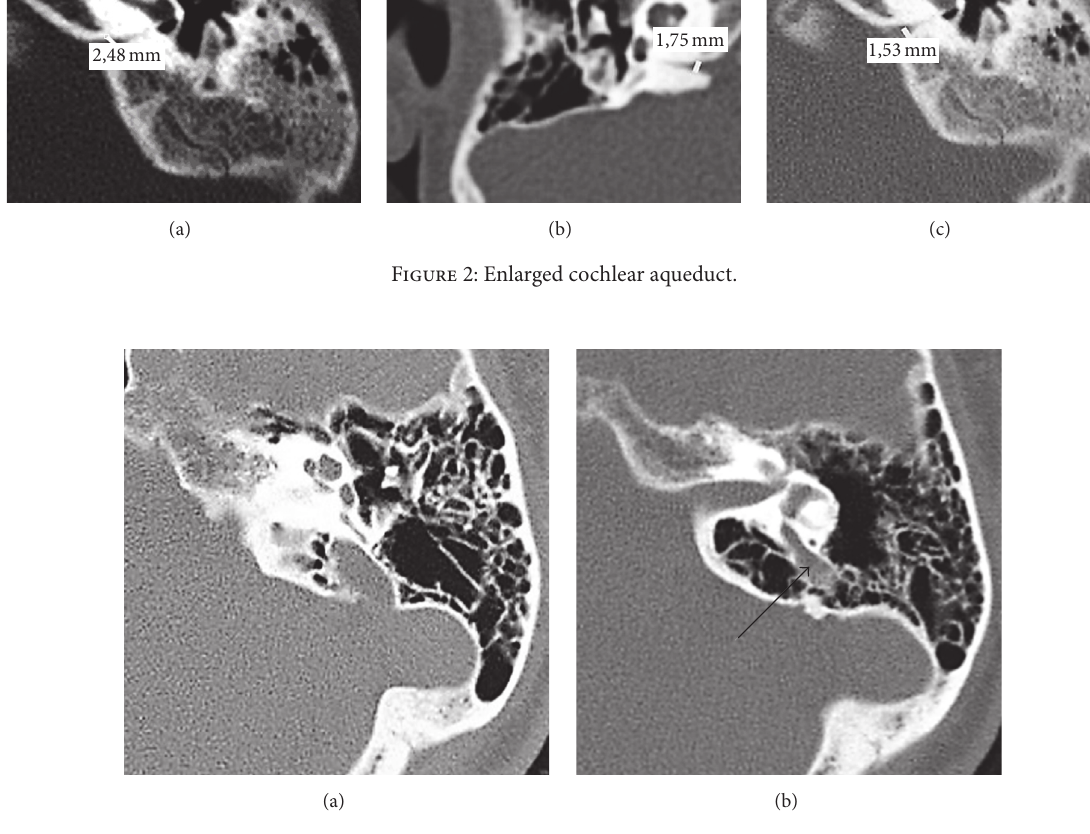
Figure 3: Enlarged vestibular